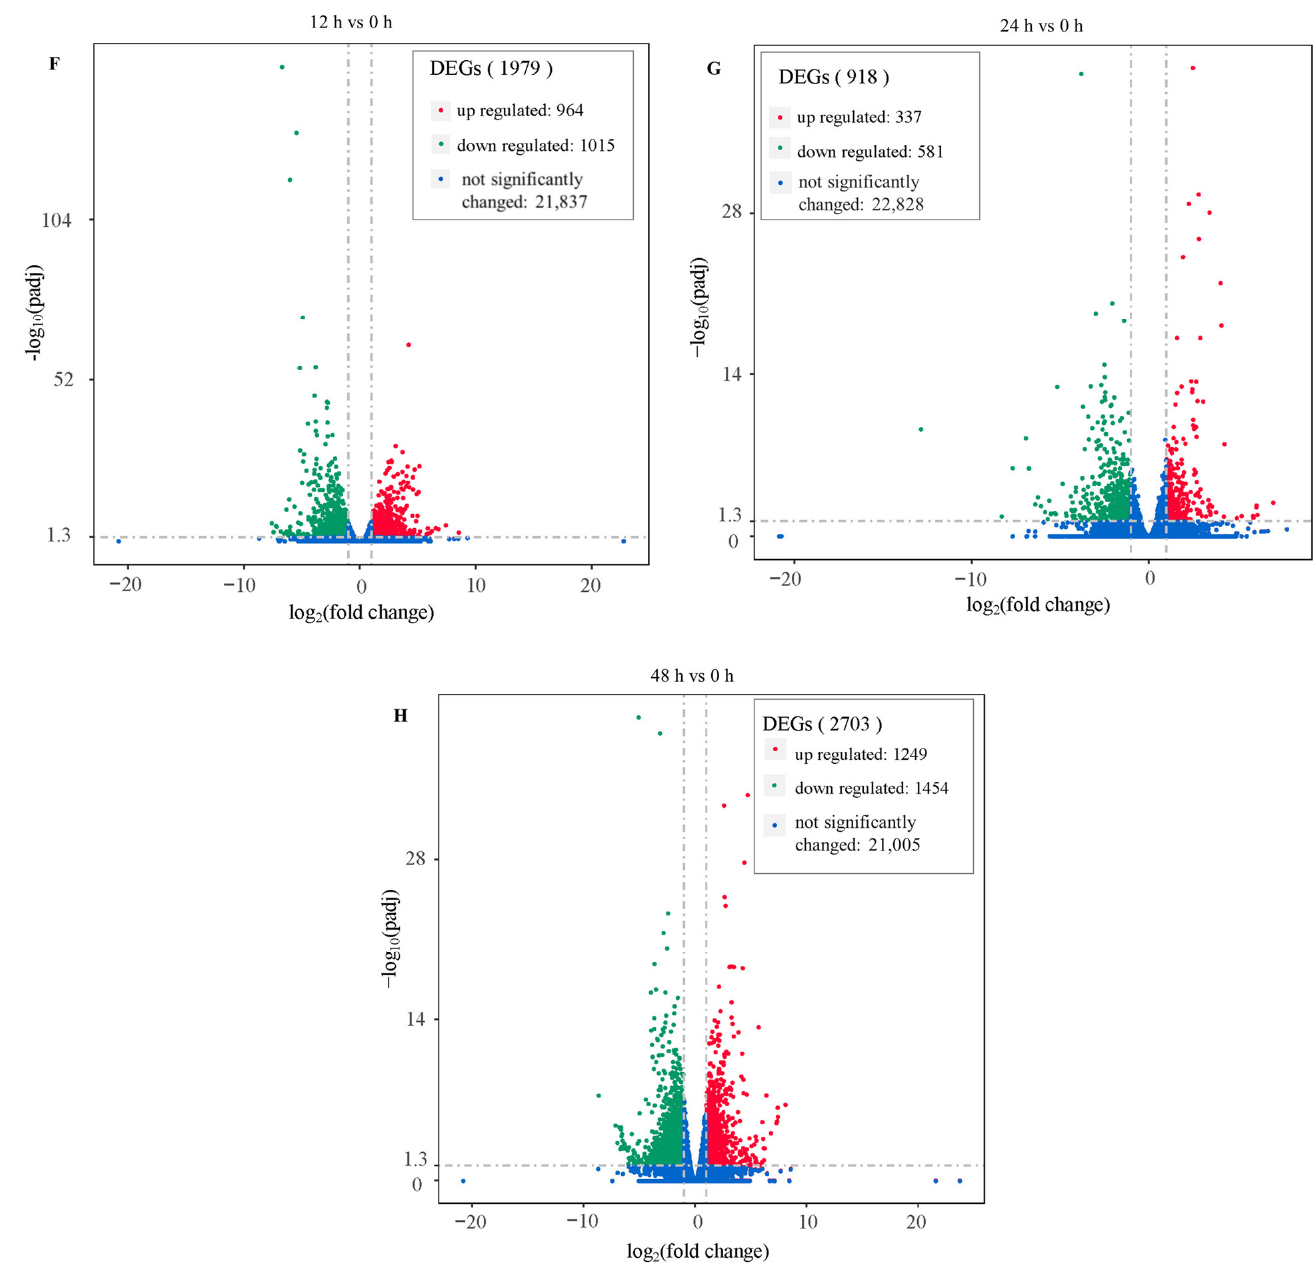
Figure 3. Differentially expressed genes (DEGs): ( A ) numbers of DEGs in each time node; ( B ) Venn diagrams for 12 h vs. 0 h and 24 h vs. 0 h; ( C ) Venn diagrams for 12 h vs. 0 h and 48 h vs. 0 h; ( D ) Venn diagrams for 24 h vs. 0 h and 48 h vs. 0 h; ( E ) Venn diagrams for 12 h vs. 0 h and 24 h vs. 0 h and 48 h vs. 0 h; ( F ) volcano plots for 12 h vs. 0 h; ( G ) volcano plots for 24 h vs. 0 h; ( H ) volcano plots for 48 h vs. 0 h.